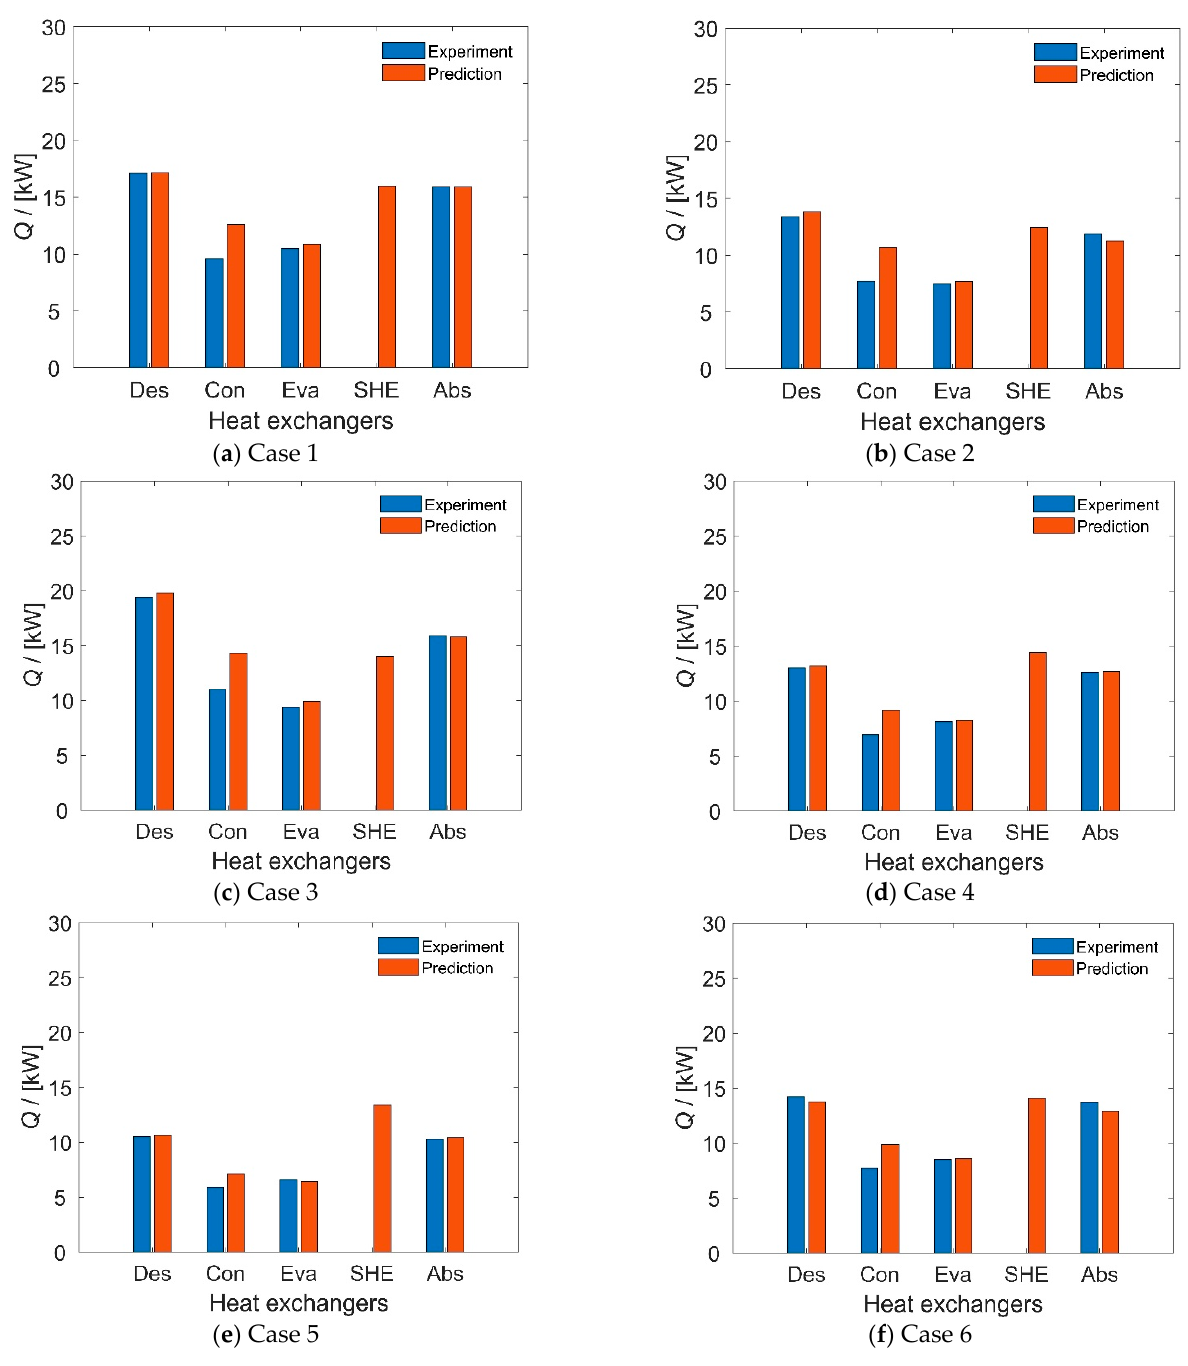
Figure 6. Comparison of the predicted heat loads through this study with the experimental data of Le Lostec et al. [19] for ( a ) Case 1, ( b ) Case 2, ( c ) Case 3, ( d ) Case 4, ( e ) Case 5, ( f ) Case 6. Generally, the experimental heat loads of the heat exchangers were accurately pre- dicted by the numerical model. The deviations of the desorber and evaporator were smaller than 4% and 6%, respectively. The predicted heat loads of the condenser were about 30% larger than the experimental values. During the experiments, to promote cool- ing, the condenser and absorber were not insulated [19]. The condenser had a high tem- perature, and the heat loss to the environment was significant. The temperature of the absorber was close to the environment, and the heat loss was minor. The experimental data of SHE was not measured. The predicted values are presented, which are comparable to that of the desorber.